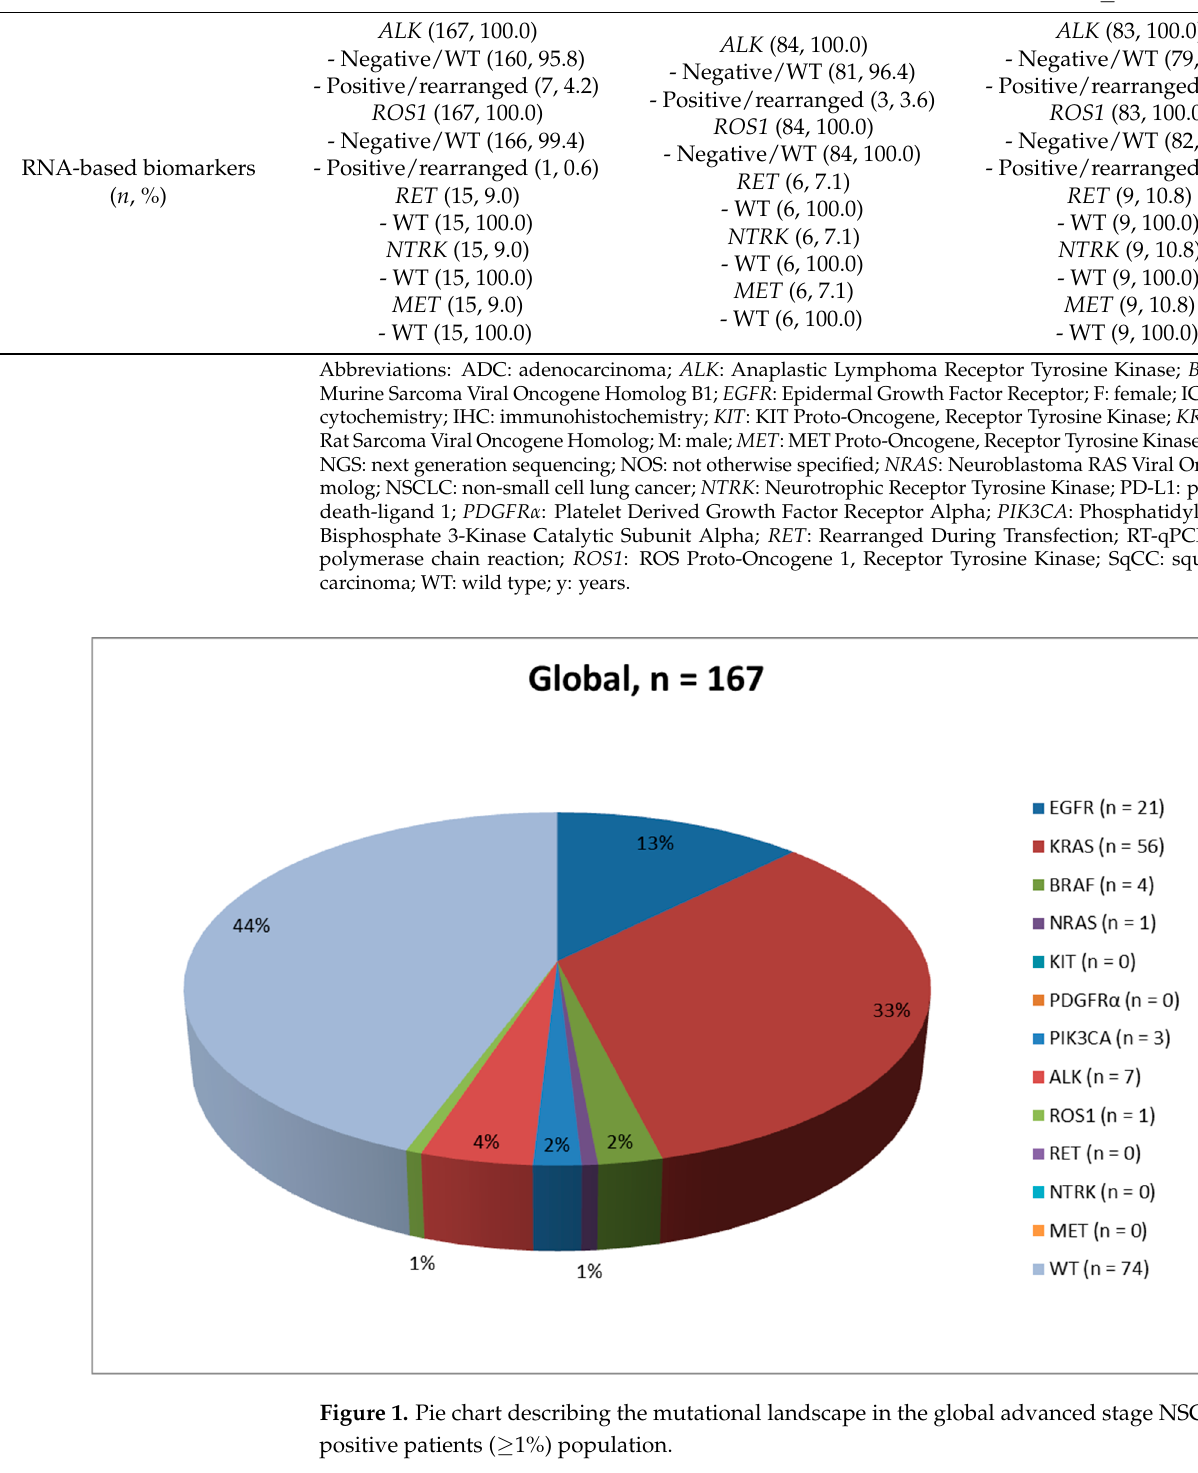
Figure 2. Pie chart describing the mutational landscape in the 1–49% PD-L1 positive advanced stage NSCLC patients population.